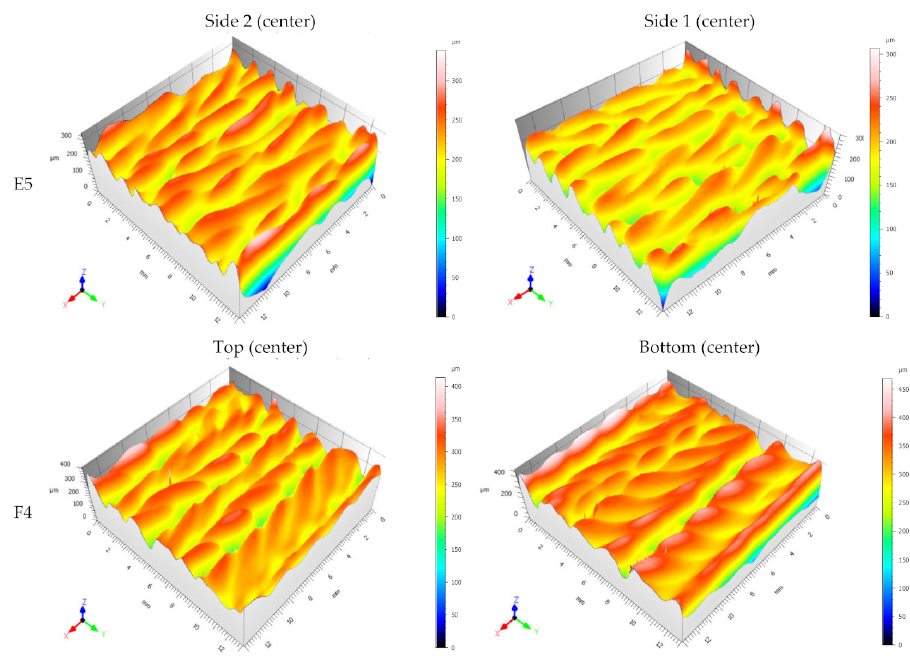
Figure 16. 3D topography of the two sides of vertical sample E5 and horizontal sample